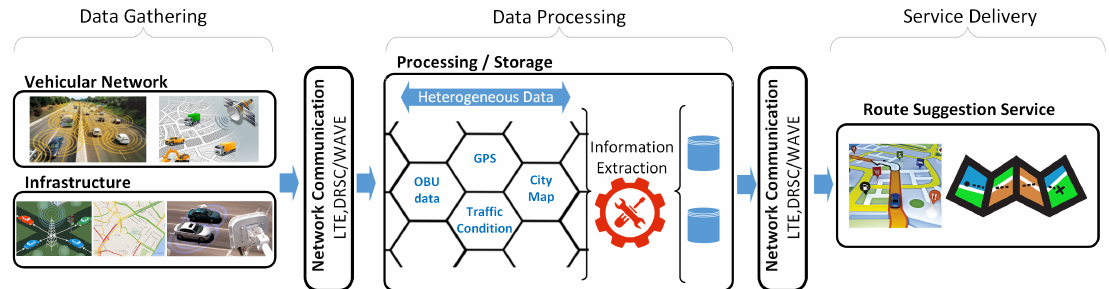
Figure 3. The data flow of the three steps of FOXS implementation